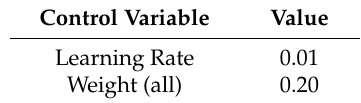
Table 1. The control variables to analyze the agricultural partial diagnosis sub-module (APDS) performance.